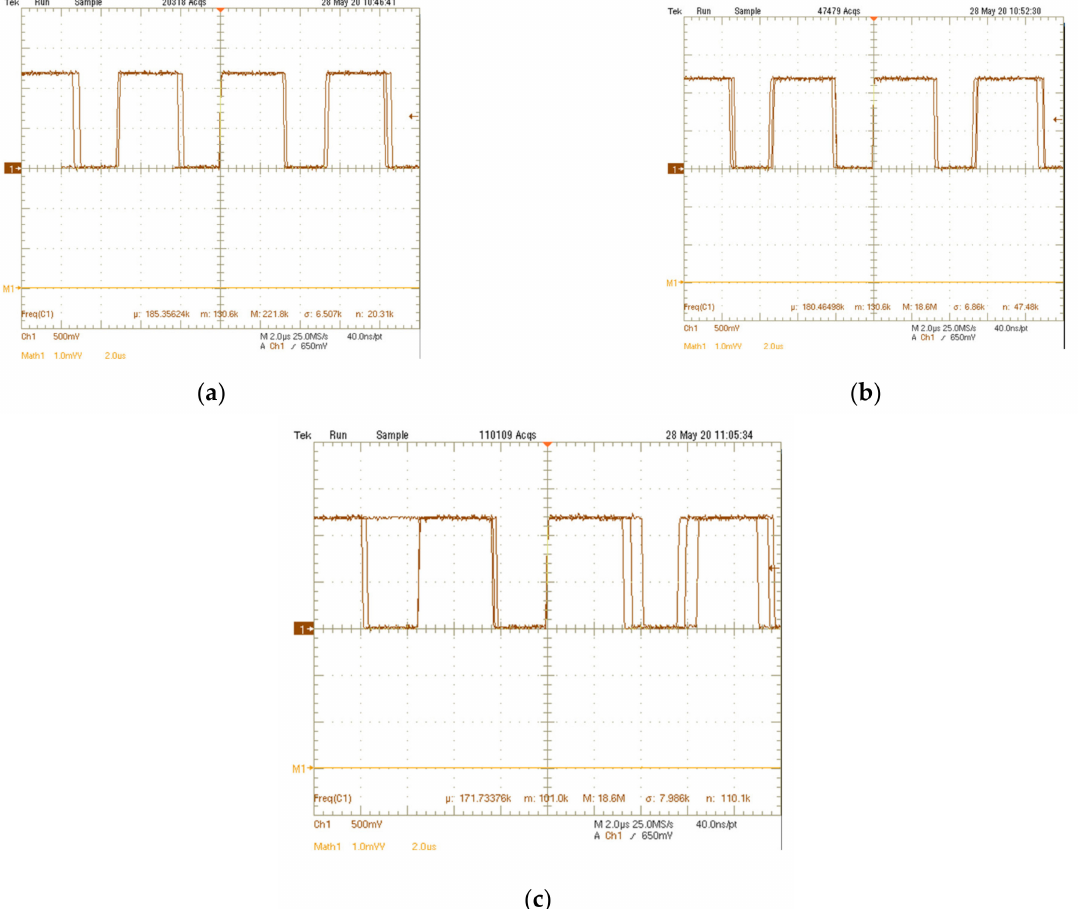
Figure 12. Measured signal at the Schmitt trigger output for the three cases in Figure 11: ( a ) low coverage; ( b ) medium coverage; ( c ) high